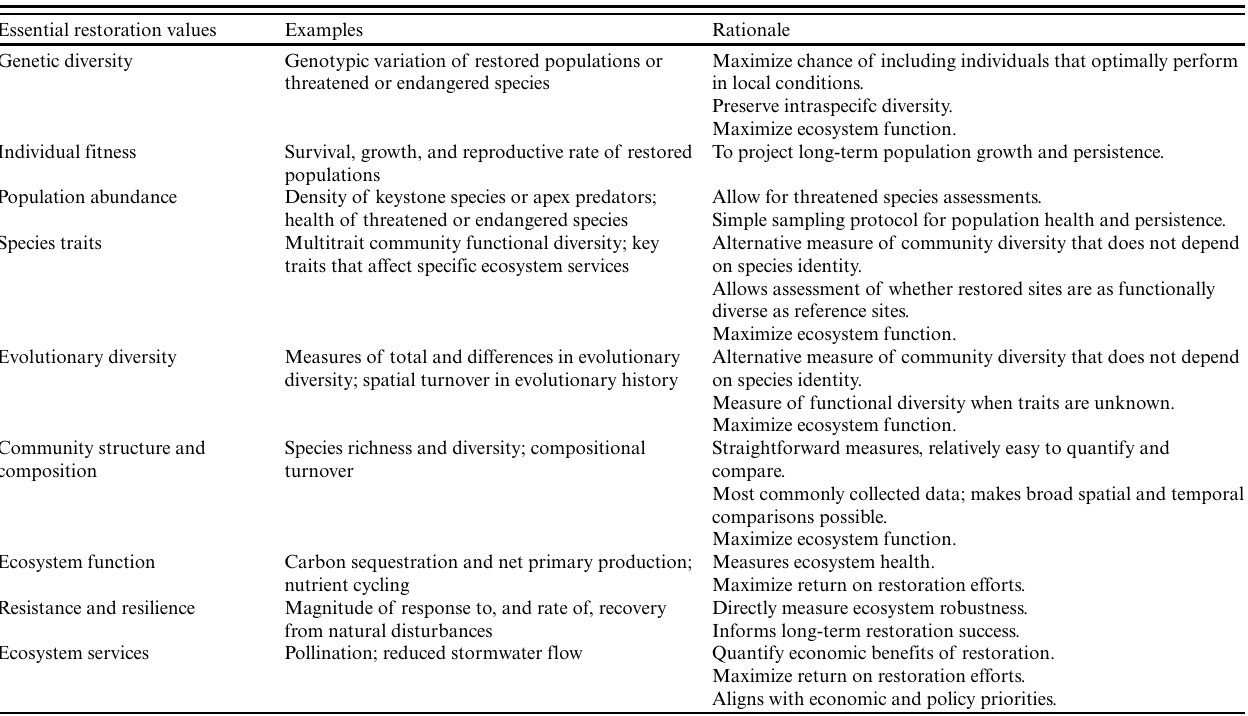
Table 1 . Examples of essential restoration values for restoration of degraded and disturbed ecosystems that align with ecological and conservation priorities (modified from Pereira et al. 2013).